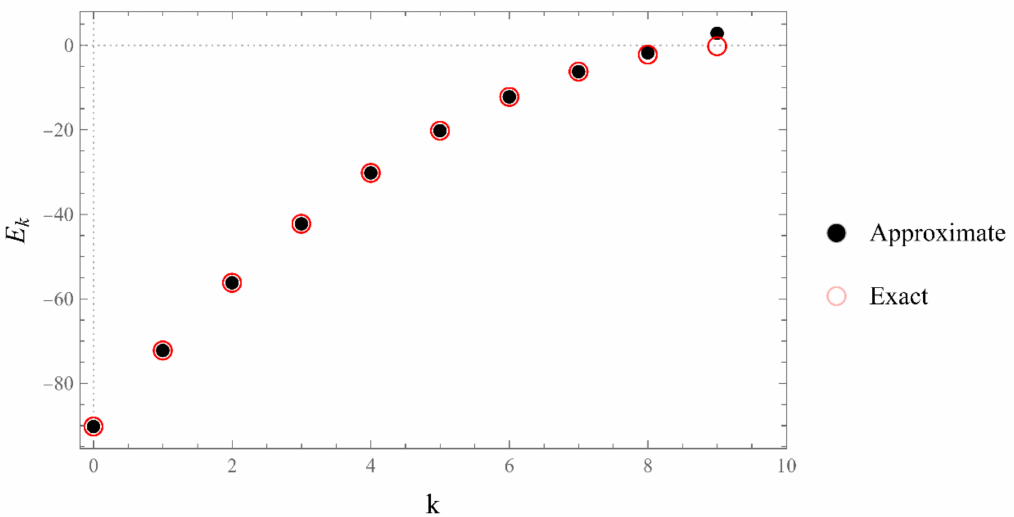
Figure A20. The k th zero of P N ( E ) vs k for N = 500. We took γ = 10 and µ = − 9.5. When E < 0, the zeros of P N ( E ) agrees with Equation (18) up to k = (cid:98)− µ (cid:99) .